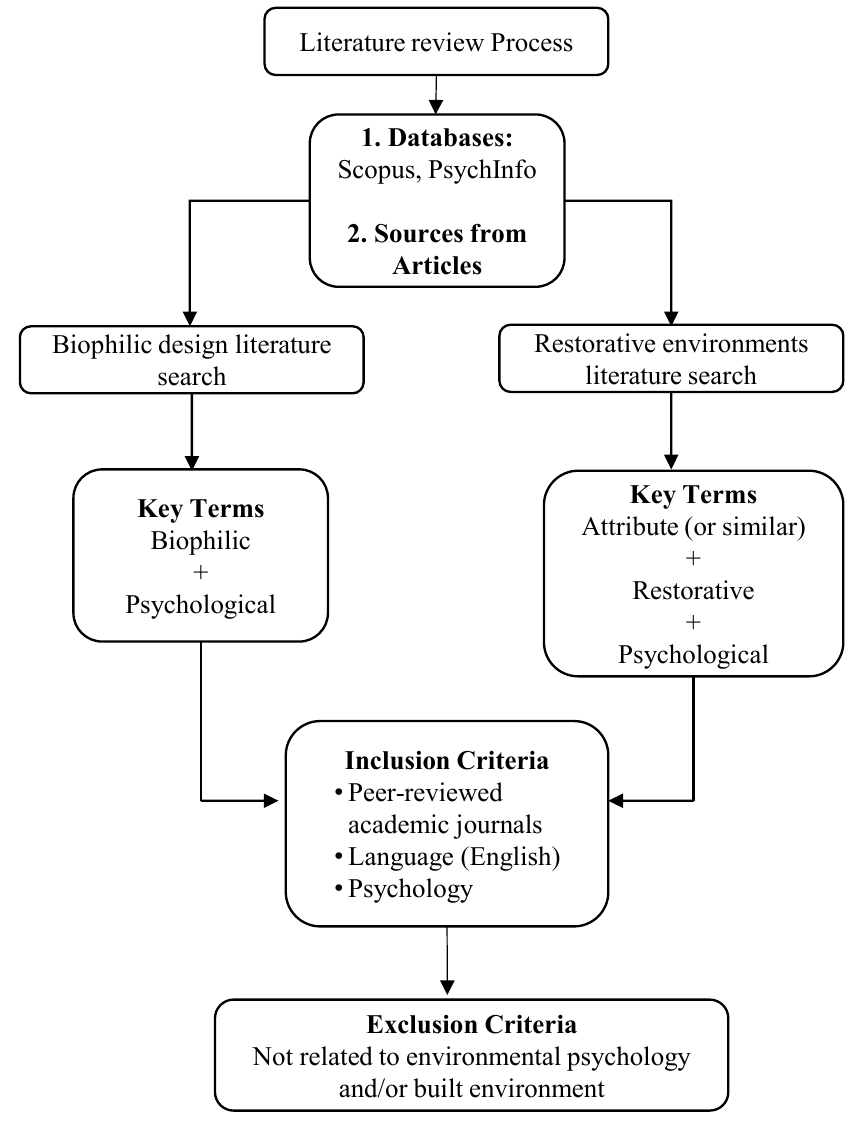
Figure 1. Narrative review